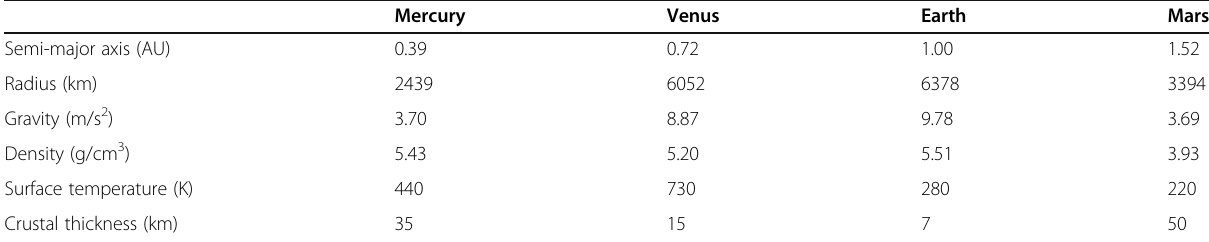
Table 1 Basic information for the terrestrial planets Mercury Venus Earth Semi-major axis